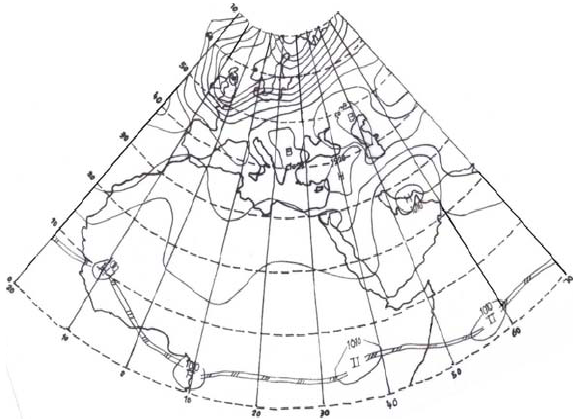
Fig. 8 The pattern of the surface isobars (AAXX) and low pressure center after the heavy rainfalls (Type II: 11 January 1978)